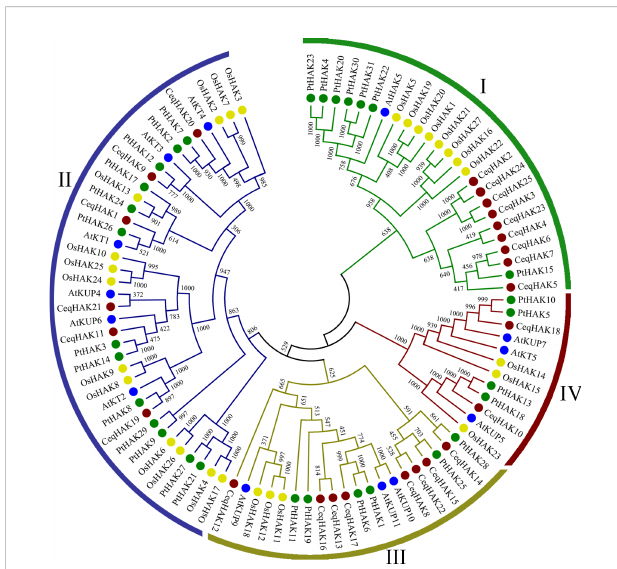
FIGURE 1 Phylogenetic tree of HAK genes from C. equisetifolia , Arabidopsis , rice and poplar. 25 CeqHAK genes, 13 AtHAK genes, 27 OsHAK genes and 31 PtHAK genes were clustered into four subgroups (I, II, III and IV). Red, blue, yellow and green shapes represent HAK genes from C. equisetifolia , Arabidopsis , rice, and poplar, respectively. The tree was generated with the MEGA 7.0 using the neighbor-joining (N-J)